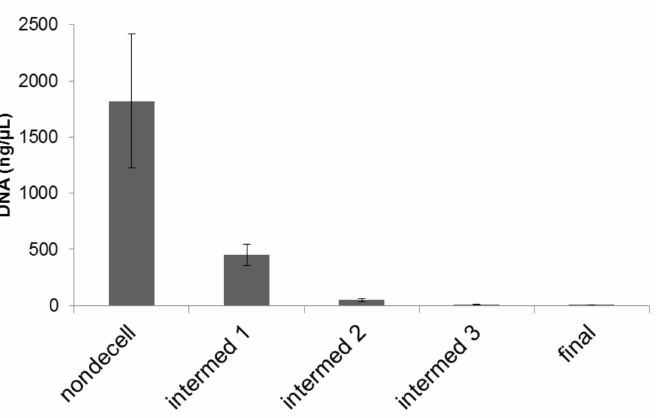
Figure 4. DNA content before, during sequential stages, and after decellularization process. DNA was extracted and quantified spectrophotometrically. Quantitative measurements of DNA within scaffolds before, during, and after decellularization process indicated that residual DNA was at approximately 24.76%, 2.63%, 0.66%, and finally 0.22% of the original content. Error bars: Mean ± standard error of the mean. N =